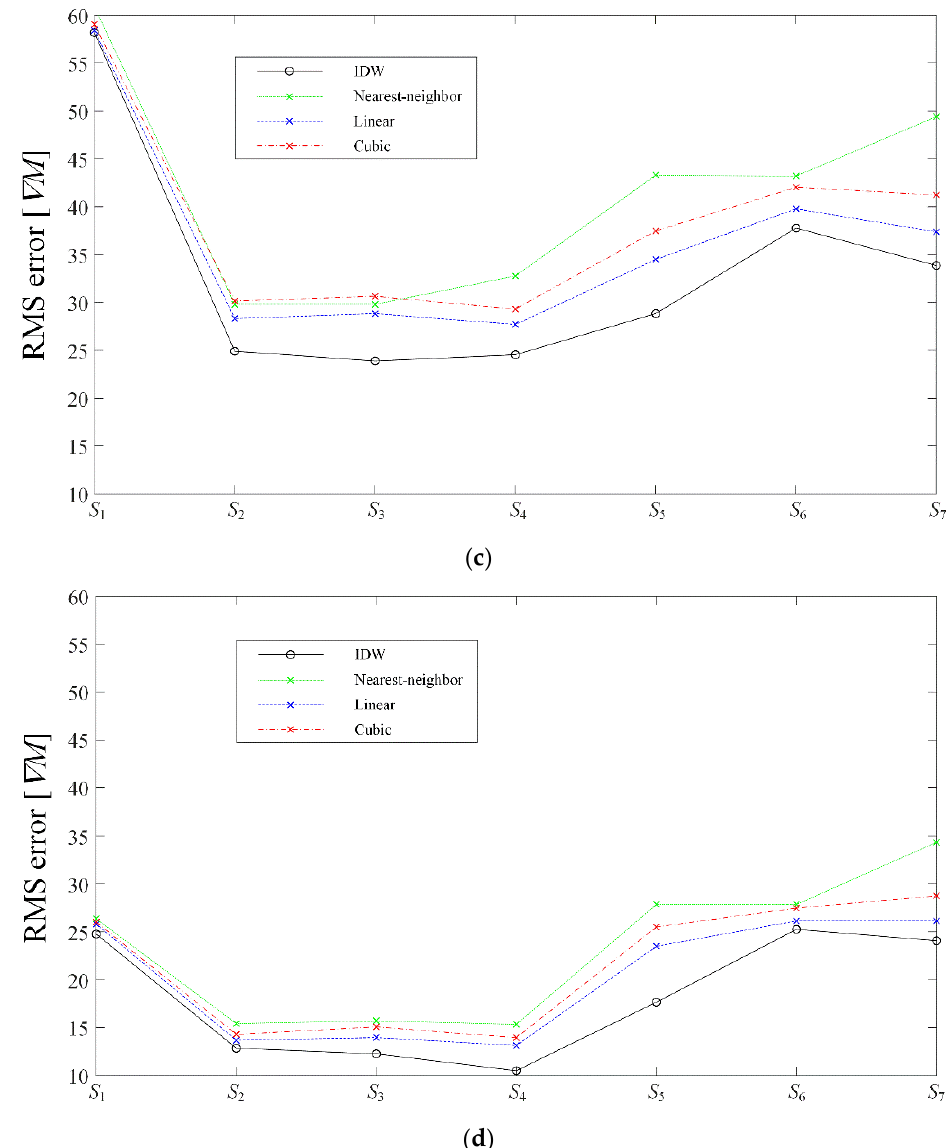
Figure 3. Root-mean-square error (RMSE) of ∇ M between the observation-based and the interpolated refractivity data from conventional linear, cubic, nearest-neighbor, and IDW interpolation methods: ( a ) spring; ( b ) summer; ( c ) autumn; and ( d ) winter. Table 2. RMSE of M results for seven observatories.